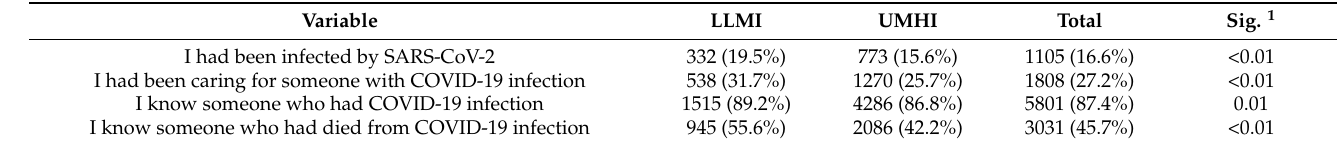
Table 3. COVID-19-related experience of the dental students stratified by economic level, February 2021.